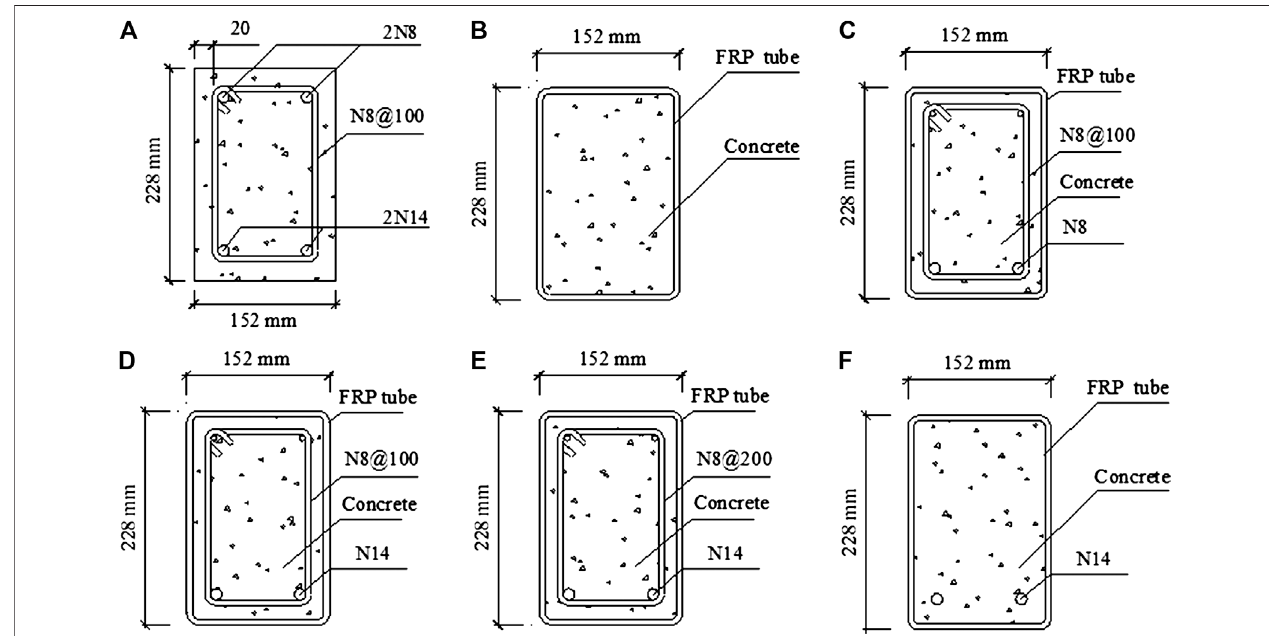
FIGURE 1 | Cross-sections of beam specimens (A) RC, (B) G0C, (C) G0.6A, (D) G1.15A, (E) G1.15B, and (F) G1.15C.